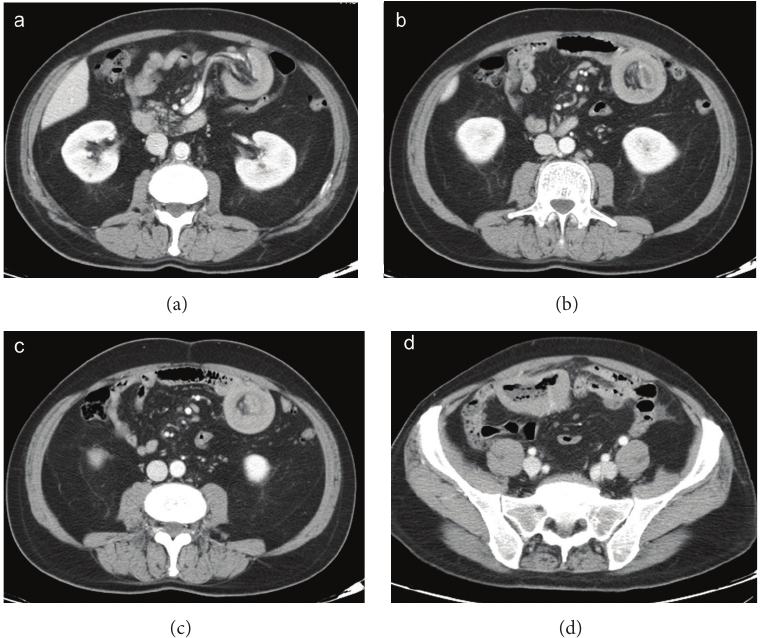
Figure 7: Enteroenteric (ileoileal) intussusception caused by lymphoma. Axial CT images show the typical appearance of small bowel intussusception (a, b, and c). Marked circumferential thickening of the wall of a distal ileum loop (d) is due to lymphoma, which is responsible for intussusception.